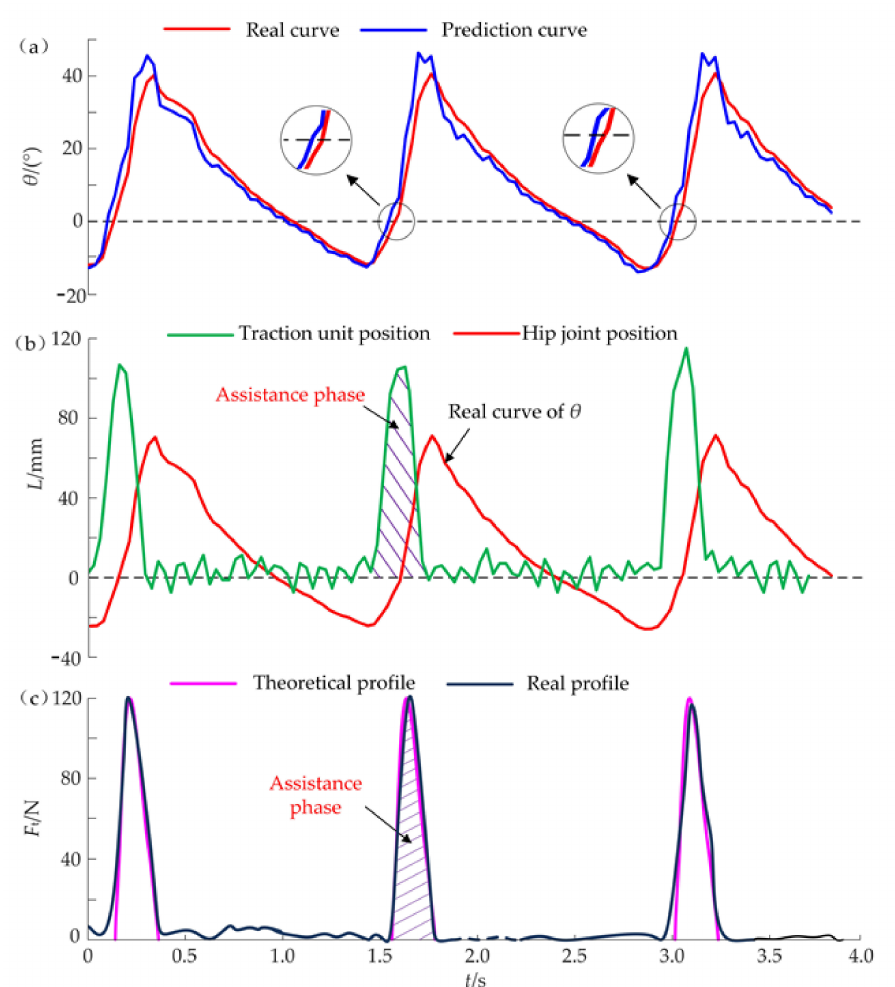
Figure 9. Experimental data of the effective assistance ( v 1 = 0.75 m/s, L c = 7 mm, ∆ t = 200 ms) ( a ) The switching time from the flexion to extension is shorter and the real curve of θ is smoother compared with that of Figure 8a. ( b ) The assistance phase dominates the whole activation interval of the H-Suit and the lag phase almost disappears. ( c ) The real profile of the auxiliary forces F t is in good agreement with the theoretical